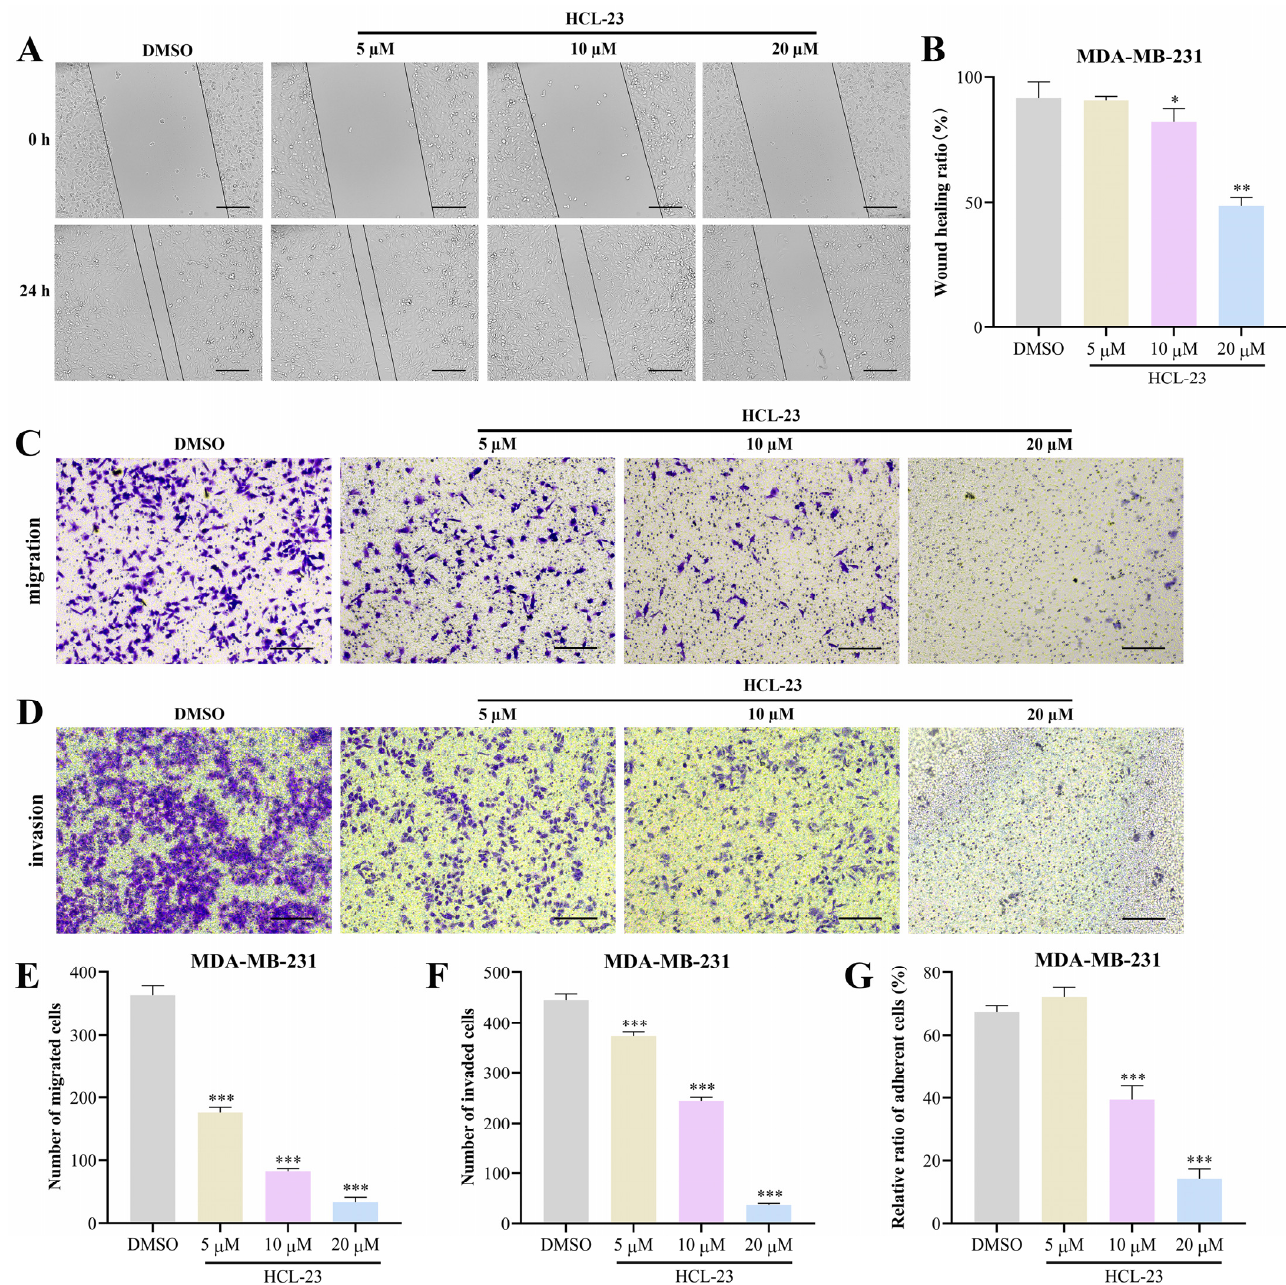
Figure 3. HCL-23 suppresses the migration, invasion, and adhesion of MDA-MB-231 cells. ( A ) Representative images of wound healing assays of MDA-MB-231 cells treated with various concentrations of HCL-23 (5, 10, 20 µM) for 0 h and 24 h (magnification × 100, scale bar: 200 µm). ( B ) Quantification of wound healing ratio (%). ( C ) Transwell migration assays of MDA-MB-231 cells treated with various concentrations of HCL-23 (5, 10, and 20 µM) for 24 h (magnification × 100, scale bar: 200 µm). ( D ) Transwell invasion assays of MDA-MB-231 cells treated with various concentrations of HCL-23 (5, 10, and 20 µM) for 24 h (magnification × 100, scale bar: 200 µm) ( E ) Quantification of the number of migrated cells. ( F ) Quantification of the number of invaded cells. ( G ) Effect of various concentrations of HCL-23 (5, 10, and 20 µM) on the cell adhesion of MDA-MB-231 cells for 24 h. Data represent the mean ± SD of three independent experiments. * p < 0.05, ** p < 0.01, *** p < 0.001 vs. the DMSO group.